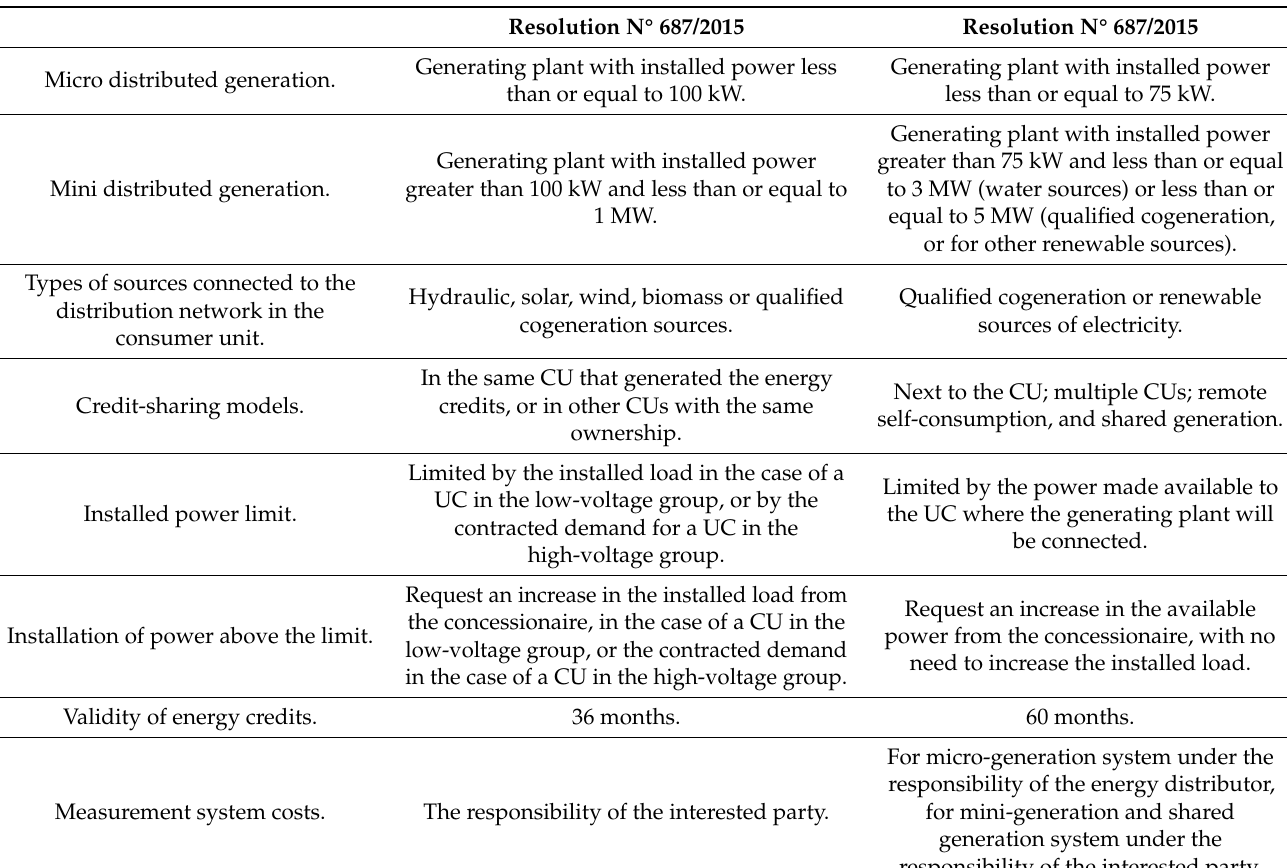
Table 3. Rules for micro and mini distributed generation (elaborated by the